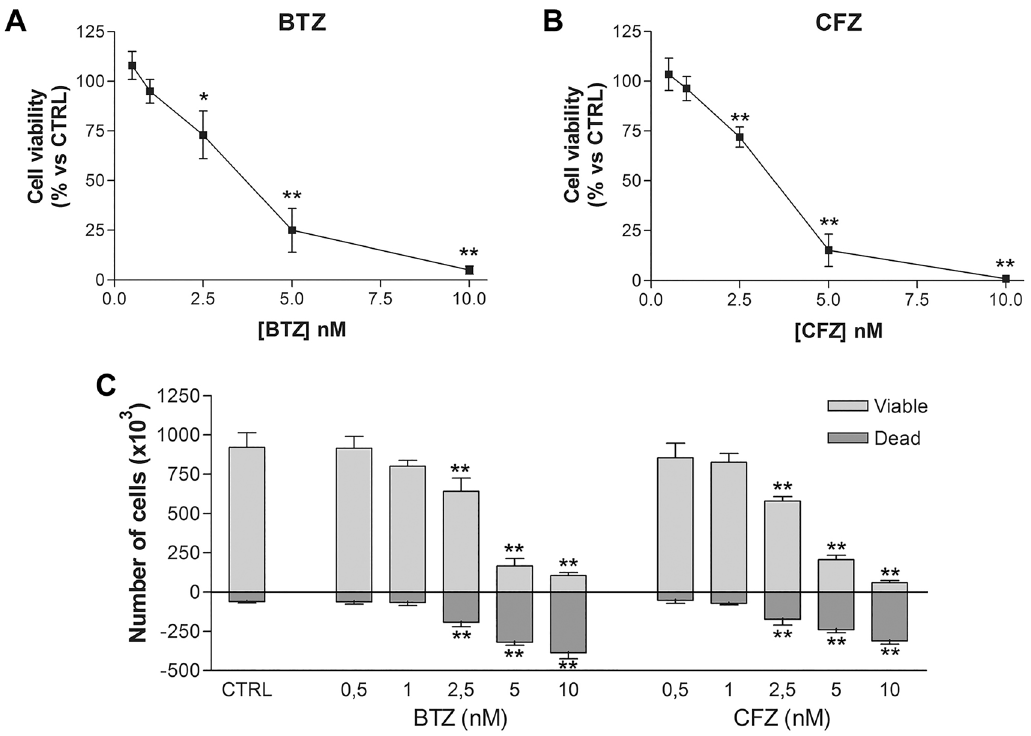
Figure 2. Cell viability of U266.B1 cells after BTZ and CFZ treatment. ( A ) MTT assay of U266.B1 cells treated for 48 h with increasing concentrations of BTZ (0.5–10 nM) or ( B ) CFZ (0.5–10 nM). ( C ) Viable and dead U266.B1 cells counted by Trypan blue vital count after 48 h of treatment with increasing concentrations of BTZ and CFZ (0.5–10 nM). All graphs are represented as mean ± SD of three independent experiments and are compared to untreated CTRL. * p < 0.05, ** p < 0.01 versus